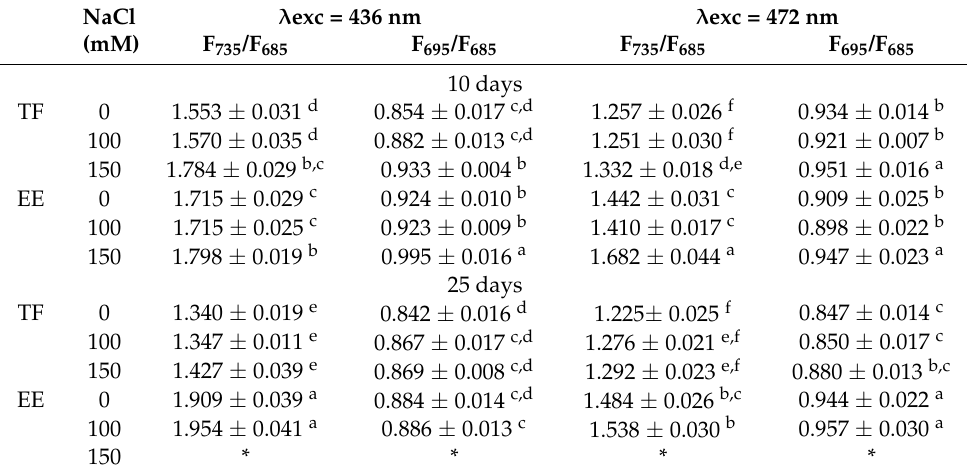
Table 1. Influence of different NaCl concentrations on the low-temperature (77 K) fluorescence emission ratios(F 695 /F 685 and F 735 /F 685 )of isolated thylakoid membranes from leaves of Paulownia tomentosa x fortunei (TF) and Paulownia elongata x elongata (EE). The plants were treated for 10 and 25 days. The thylakoid membranes were excited with 436 nm and 472 nm. Means values ( ±